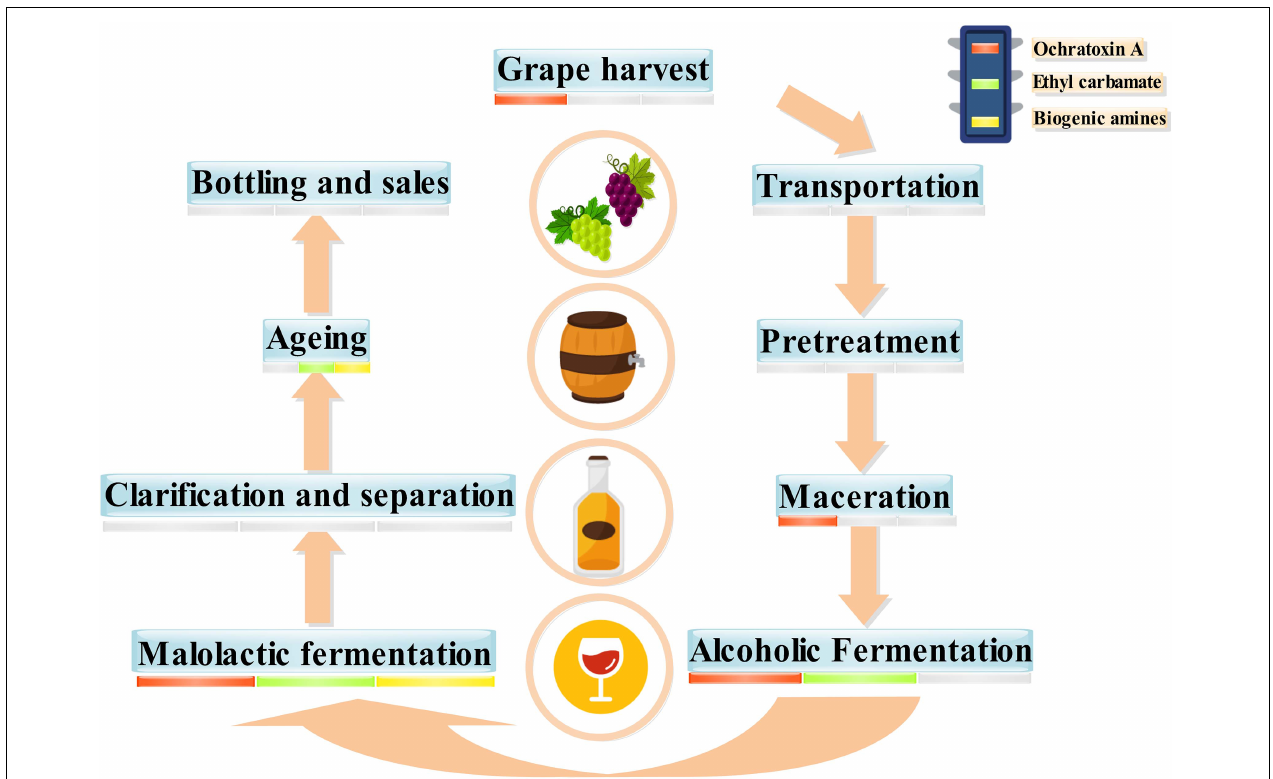
FIGURE 2 | Winemaking process and possible safety